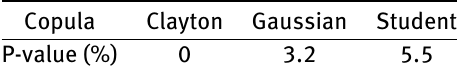
Table 4: P-values of goodness-of-fit tests of ( X 1, t −1 , X 2, t −1 , X 1, t , X 2, t ) computed with 1000 bootstrap